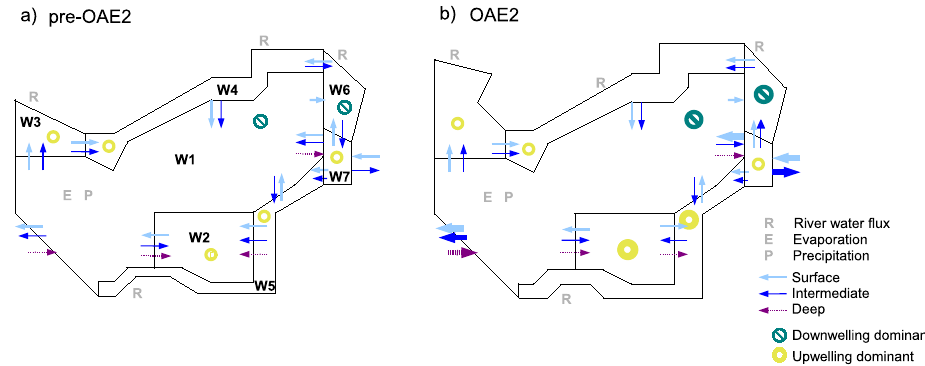
Fig. 3. Schematic showing the subdivision of the proto-North Atlantic into seven boxes (not to scale) for (a) pre-OAE2 and (b) OAE2 conditions. The symbols R, E and P indicate locations where river water fluxes, evaporation and precipitation are included in the model. Horizontal arrows indicate lateral flows of water. The regions dominated by upwelling and downwelling are also indicated. Enlarged symbols indicate a significant increase in the water flux during